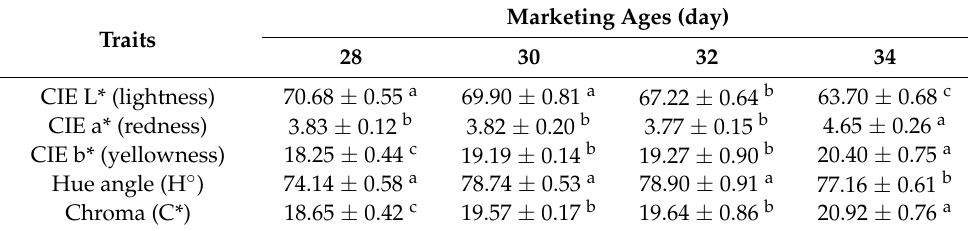
Table 3. Color of cooked cured chicken breast with various marketing ages.